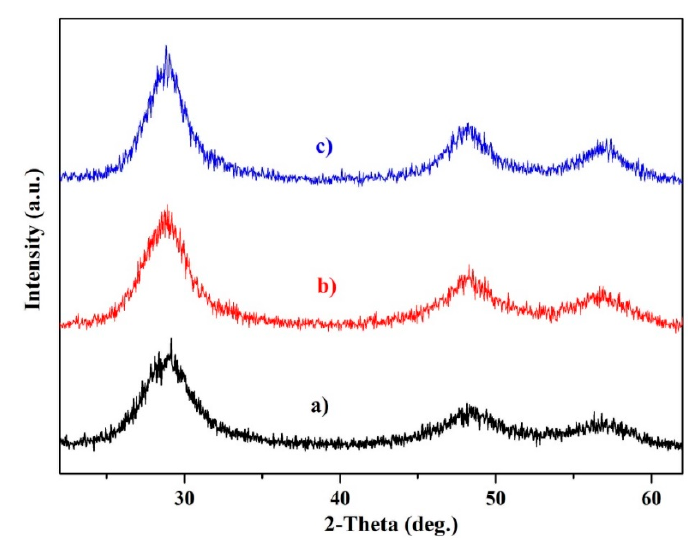
Figure 2. X-ray diffraction patterns of zinc sulfide (ZnS) nanocrystals: a ) ZnS quantum dots (Q-ZnS)-I (black curve), b ) Q-ZnS-I ʹ (red curve), c ) Q-ZnS-I ʹʹ (blue curve).